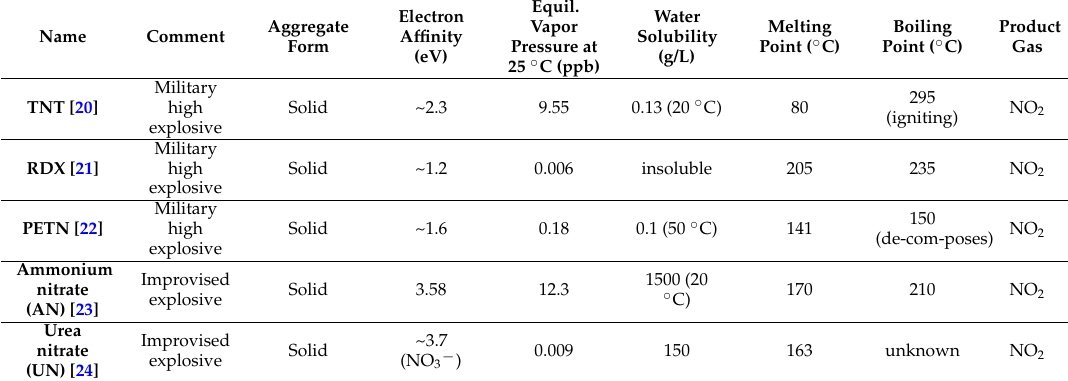
Table 1. Molecular properties of important explosives materials. Most electron affinities are theoretical estimates [19].